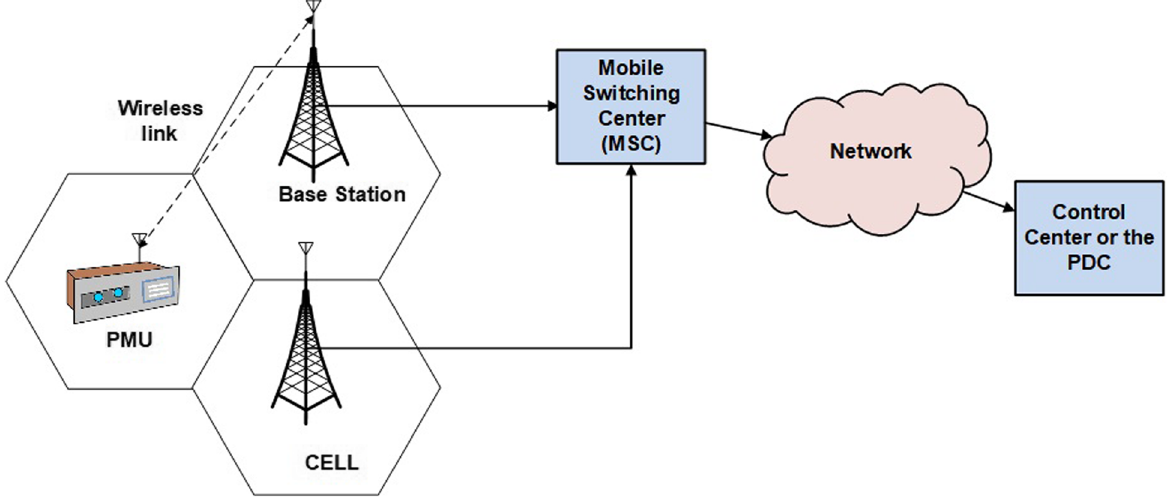
Fig. 9 Cellular Technology Based Synchrophasor Communication System